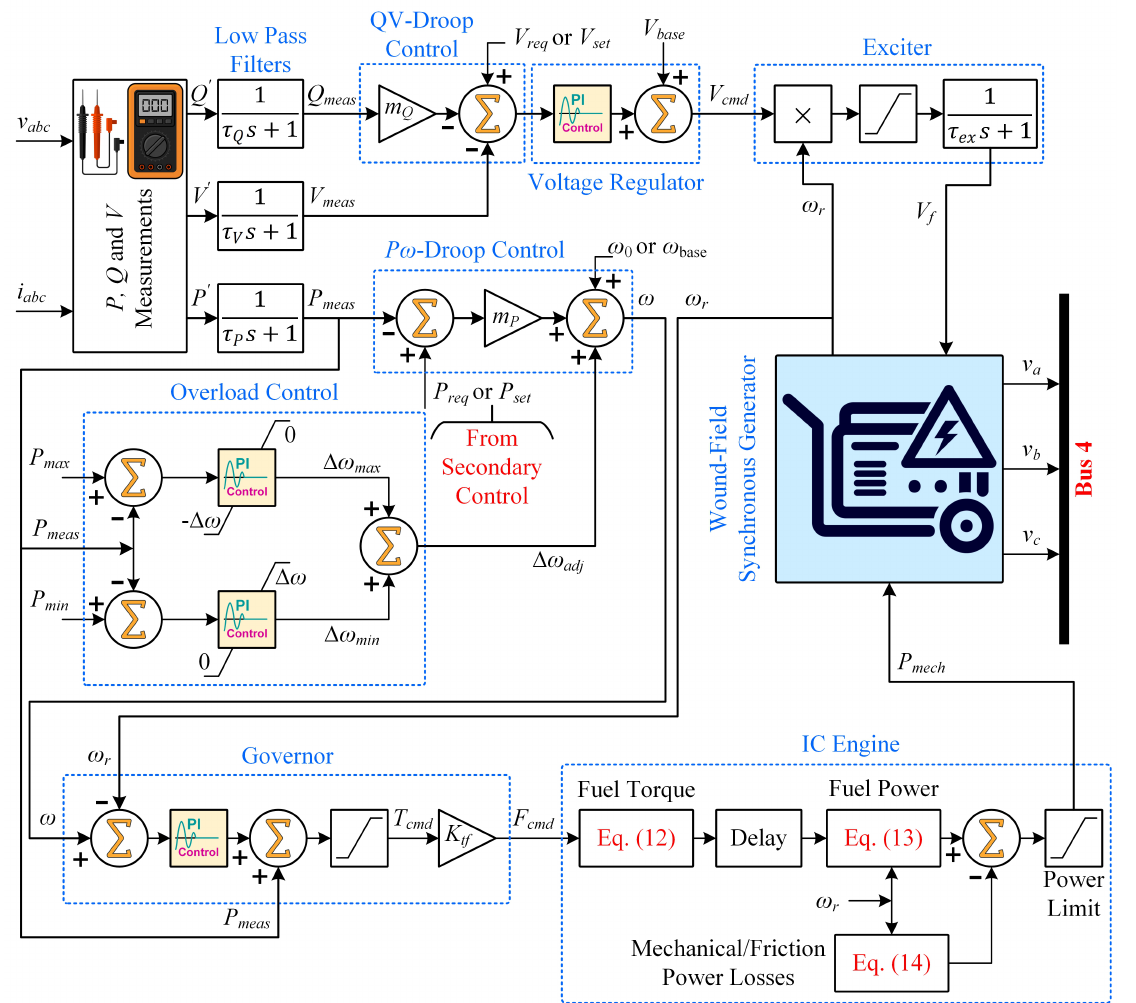
Figure 4. Droop/primary control and overload control for